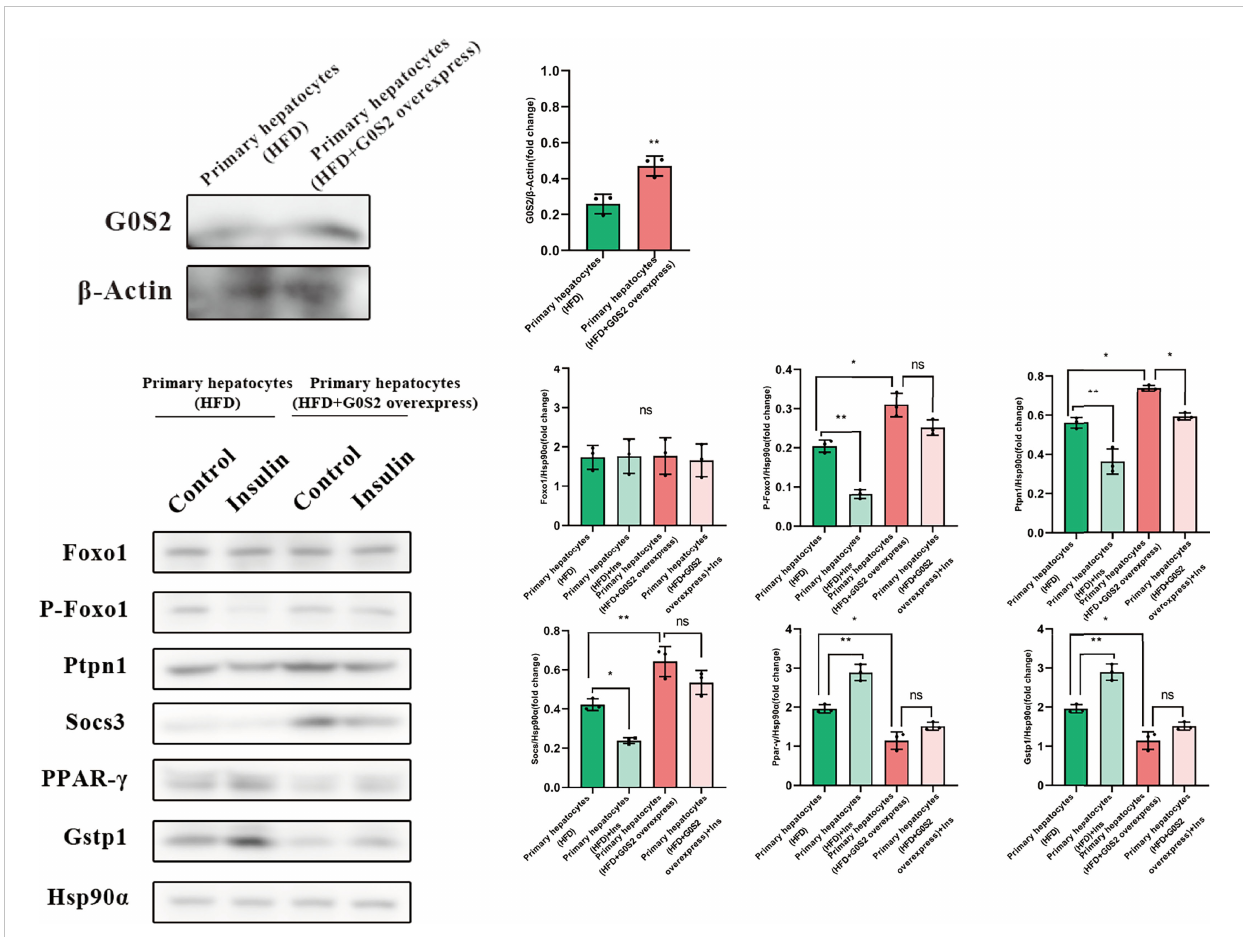
FIGURE 8 The proteins involved in insulin resistance were evaluated using western blotting analysis in primary mouse hepatocytes. Downregulation of the phosphatases Foxo1, Socs3, and Ptpn1, as well as upregulation of Gstp1 and PPAR- g , were determined in primary mouse hepatocytes isolated from G0S2 -overexpressing mice (HFD+G0S2 overexpression) by western blotting. *P<0.05, **P<0.01, ns